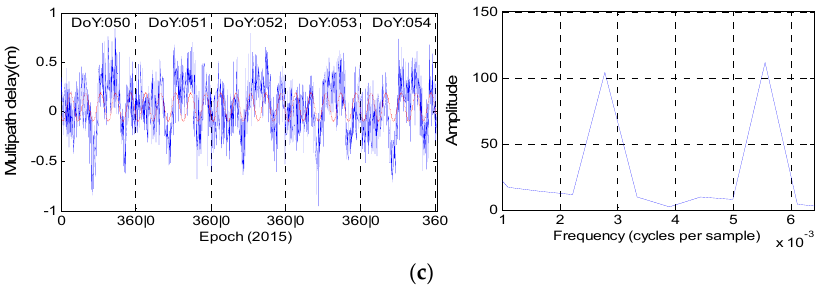
Figure 11. The fitted curve ( red line ) and its corresponding magnitude spectrum ( right ) for C01 ( a ); C02 ( b ) and C04 ( c ) at station JFNG. The observation sampling rate is 240 s.